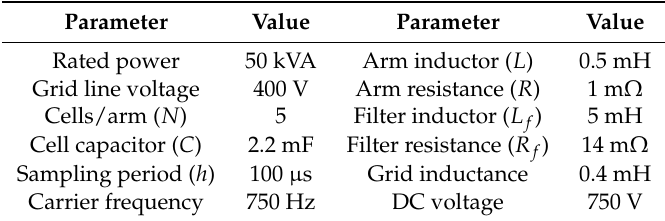
Table 1. Simulation and prototype